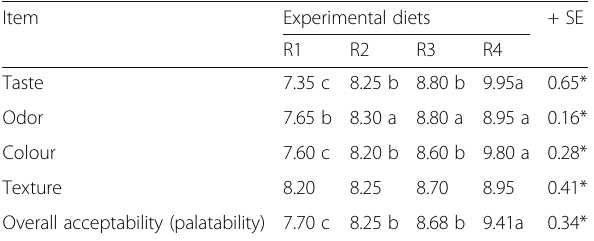
Table 6 Effect of the experimental diets on sensory evaluation parameters of commercial Cobb broilers